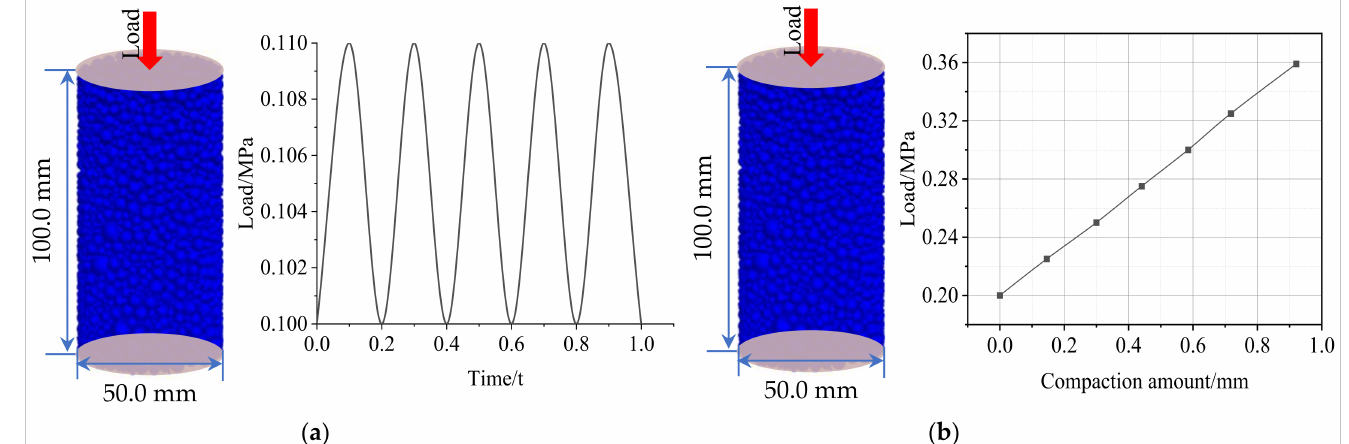
Figure 7. Numerical simulation scheme of sand-gabion; ( a ) Vibration test (x-axis shows the time, y-axis shows the excitation force); ( b ) Static load test (x-axis shows the compaction amount, y-axis shows the Static